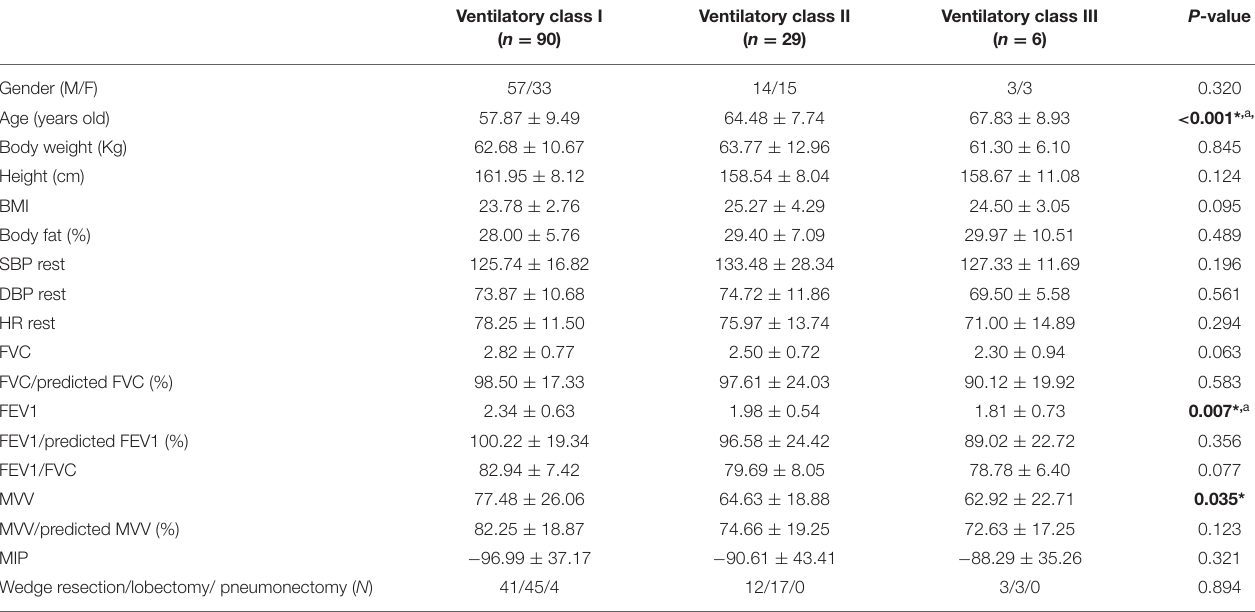
TABLE 2C | Baseline characteristics of each group defined by slope of minute ventilation and carbon dioxide production (V E /V CO2